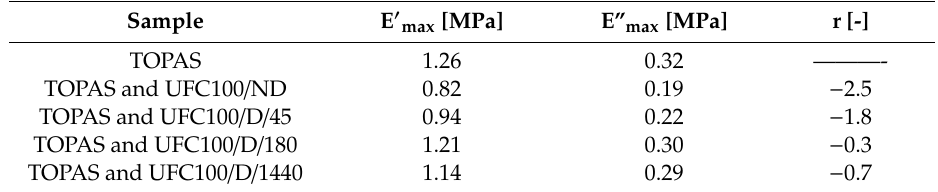
Table 7. Tabularized maximum values of storage (E (cid:48) ), loss moduli (E”), and the calculated filler e ffi ciency factor (r). Sample E (cid:48) max [MPa] E” max [MPa] r [-] TOPAS 1.26 ———- TOPAS and UFC100 / ND 0.82 TOPAS and UFC100 / D /